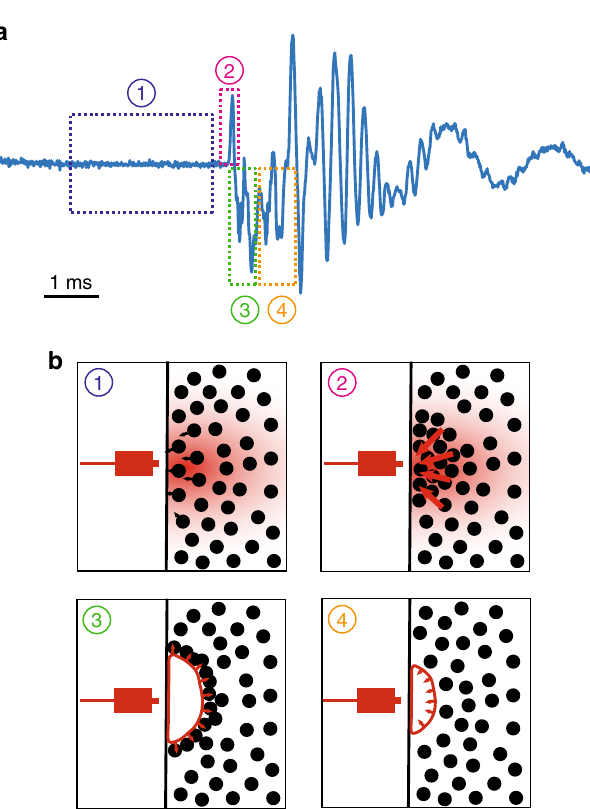
Fig. 4 Schematic mechanism of the photomechanical effect. a Force vs. time signal corresponding to a force spike. The four dashed rectangles correspond to the four steps in the proposed mechanism for the generation of a spike. b Schematics for the four steps highlighted in a . The black circles correspond to PbS particles and the red colour represents a temperature gradient. (1) Phoretic motion of the particles towards the laser source. (2) Jeans ’ instability, resulting in brutal force release. (3) Explosive growth of a bubble, which disperses the accumulated particles. (4) Collapse of the bubble and return to the initial